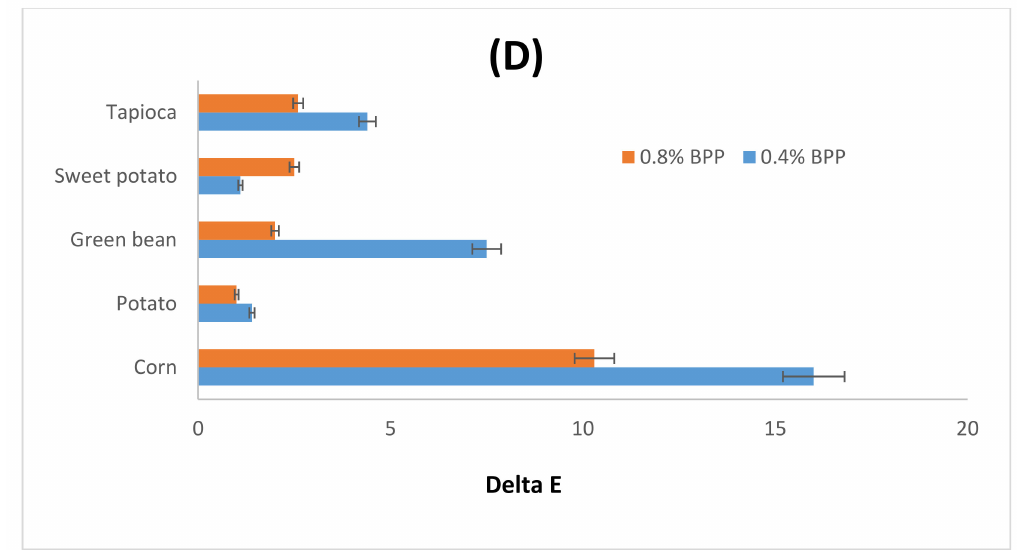
Figure 2. The L ( A ), a ( B ), b ( C ) and total color di ff erence ( D ) values of the developed films made with 0%, 0.4% and 0.8% BPP with each starch type. Data points represent the mean of ten measurement and error bars denote standard